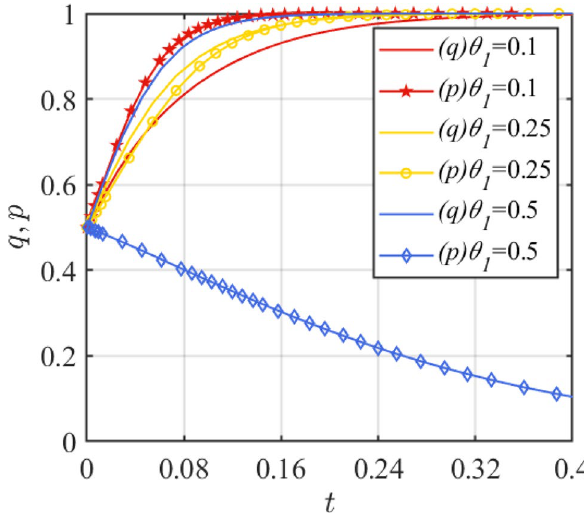
Figure 9. Effect of parameter θ 1 change.